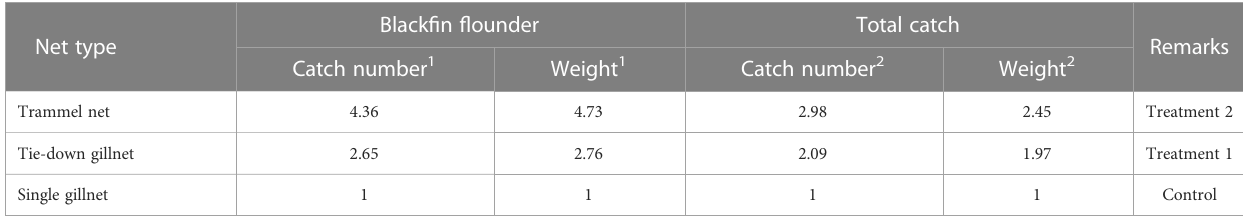
TABLE 4 The relative fi shing performance of three types of gillnets, based on the catch number or weight of black fi n fl ounder and total catch.